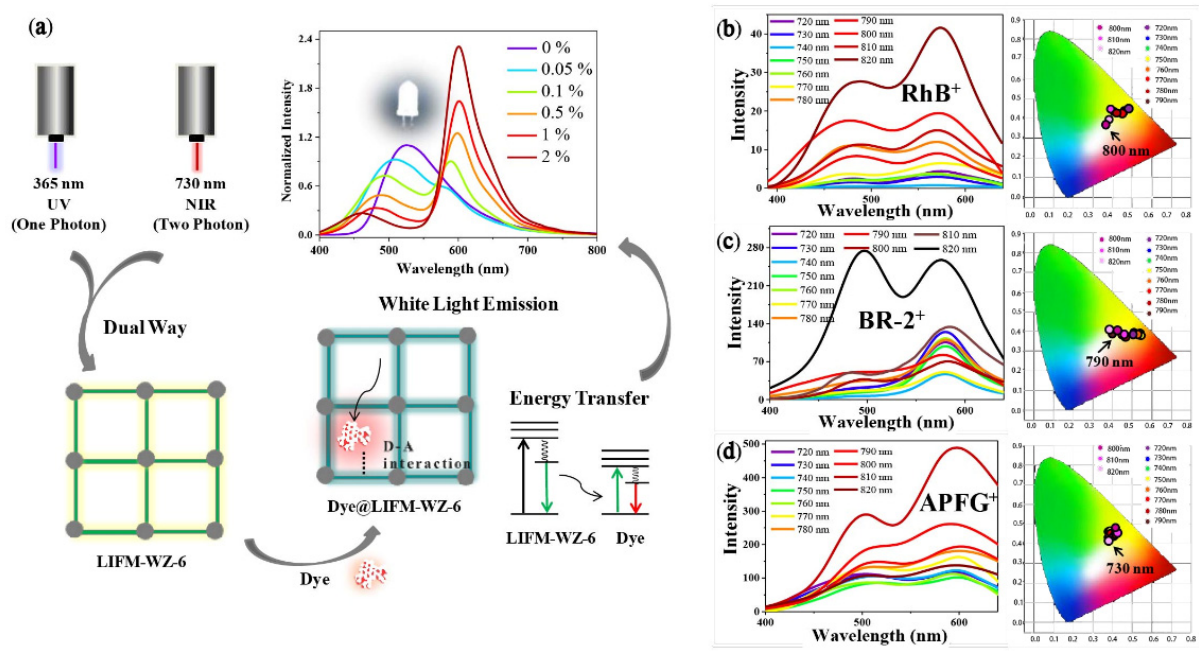
Figure 5. ( a ) Schematic illustration of OPA and TPA dual-way excited white-light emission in dye@LIFM-WZ-6; ( b ) TPEF spectra and CIE coordinate values of RhB+@LIFM-WZ-6 (0.05 wt%); ( c ) TPEF spectra and CIE coordinate values of BR-2+@LIFM-WZ-6 (1 wt%); ( d ) TPEF spectra and CIE